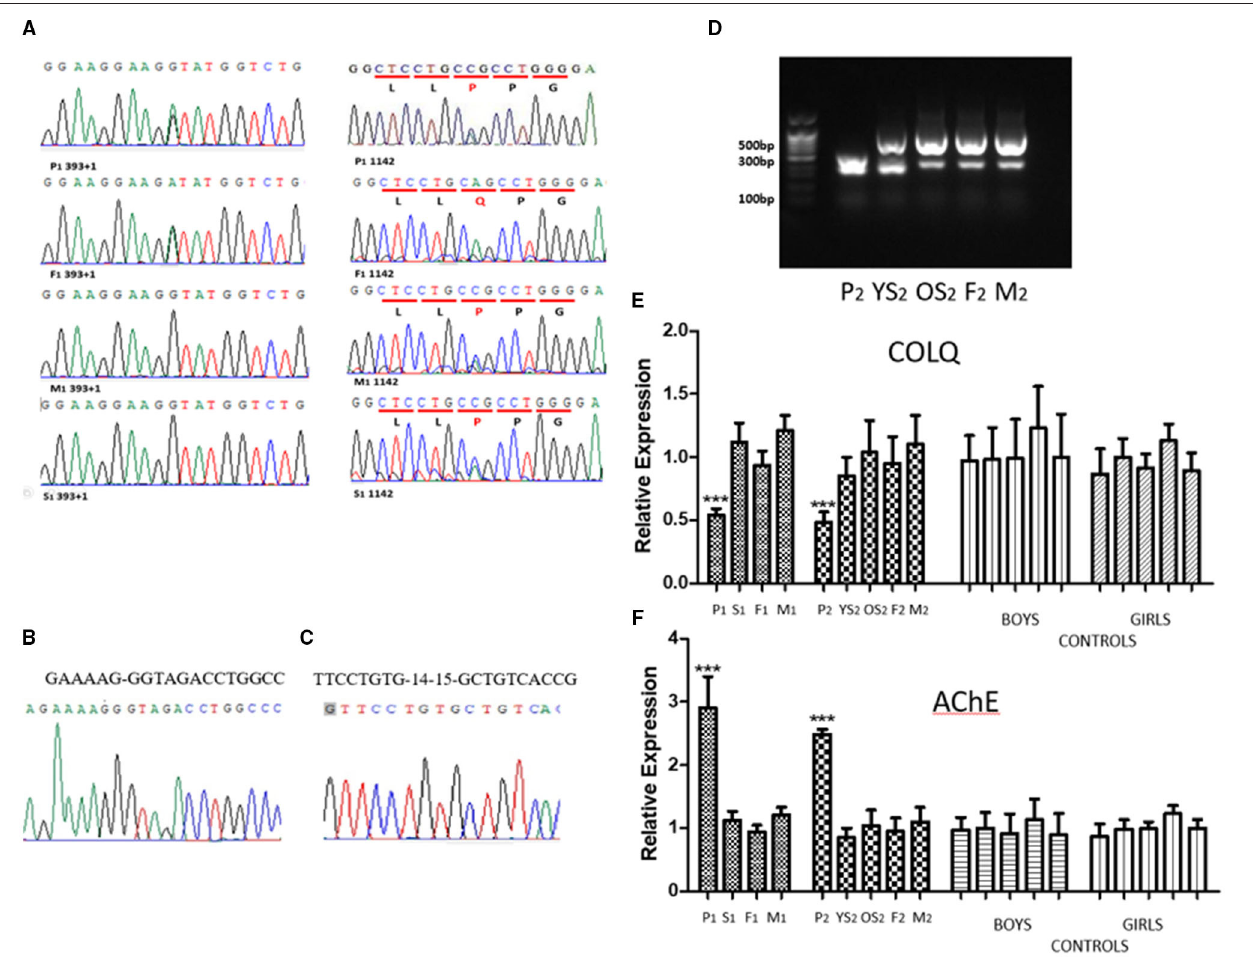
FIGURE 1 | (A) The sequences of genomic DNA in the nuclear family of proband 1, with detection of a novel heterozygous splicing mutation in COLQ (c.393 + 1G > A) from the father and a missense mutation, c.1142A > C (p.Q381P) from the mother. His sister Inherited the missense mutation, c.1142A > C (p.Q381P) from mother. (B) The sequencing results of splicing mutation in COLQ (c.393 + 1G > A). (C) The sequencing results of deletion of COLQ exons 14–15. (D) PCR results of cDNA from the nuclear family of proband 2. Proband 2 (P2) produced only one truncated band, whereas both the parents (F2&M2) and sisters (P2YS& P2OS) had two identical truncated bands. (E) qPCR analysis. The expression level of the COLQ gene in proband 1 (P1) and proband 2 (P2) was significantly lower than that of the normal level. No decreased expression was observed in the proband’s parents or sisters. (F) qPCR analysis. The expression level of the AChE gene in the two probands was significantly higher than that of the normal level. No decreased expression was observed in the proband’s parents or